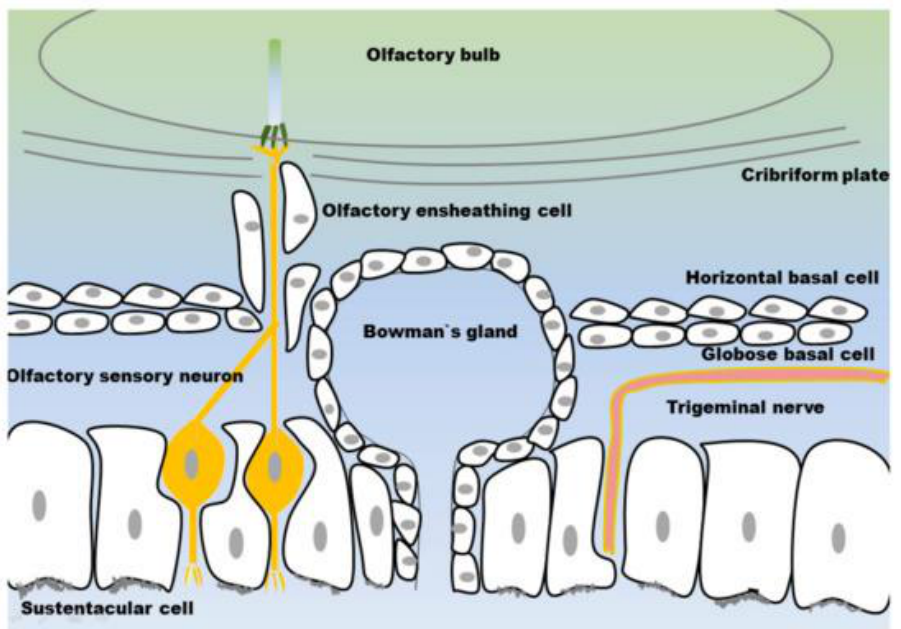
Figure 2. Comparison of olfactory ( left ) and respiratory epithelia ( right ), including location of the neurons within the sustentacular cell layers. The olfactory sensory neuron’s exposure to the nasal cavity helps explain the olfactory nerve’s larger role in intranasal delivery. Reprinted with permission from ref [15]. 2018 Stella Gänger.